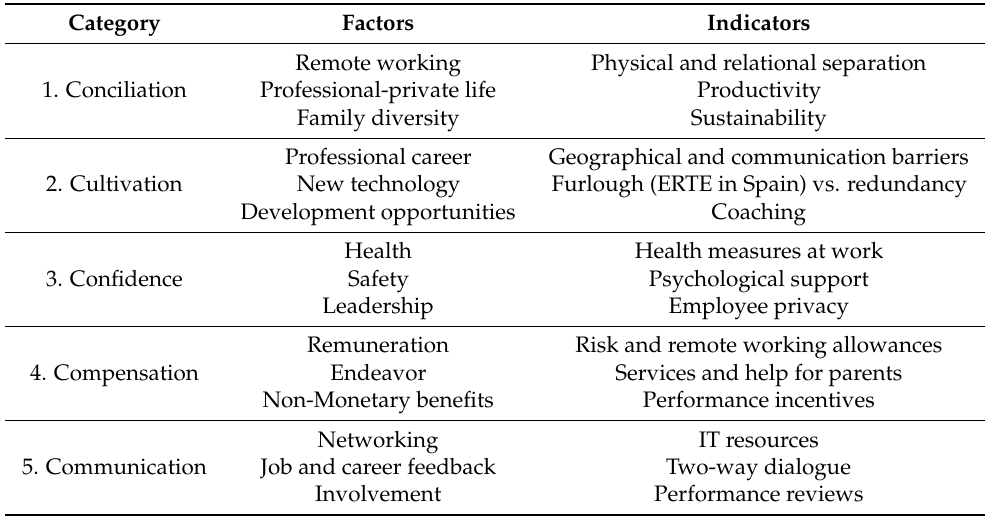
Table 2. 5C model for reinforcing employee engagement in times of COVID-19 and assessment